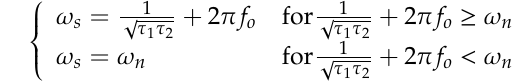
Figure 11. New feedback circuit for the power generator active bridge using a capacitor as the load of the current transformer (CT) and a variable lagging phase shifter.